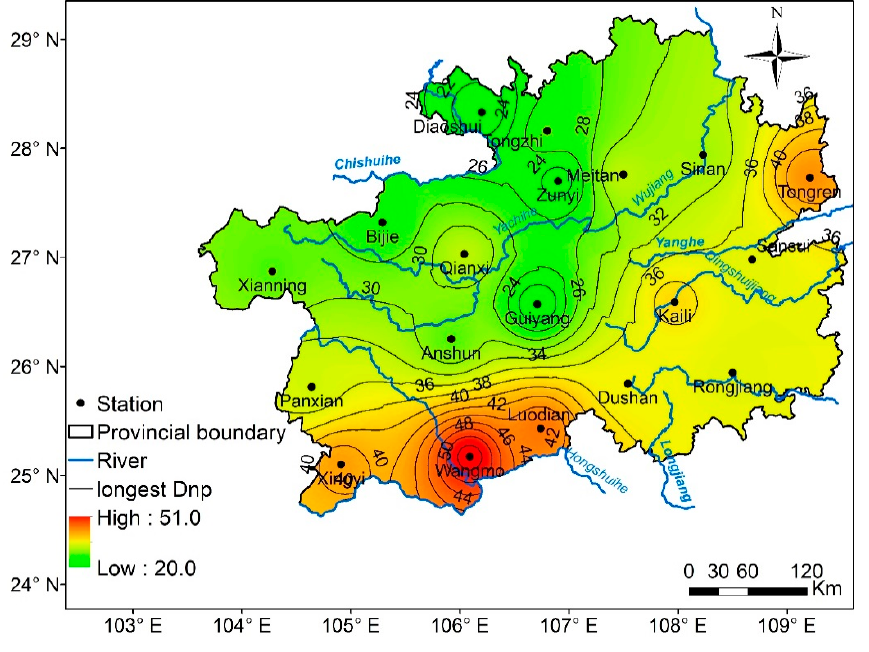
Figure 7. The spatial distribution of longest Dnp.